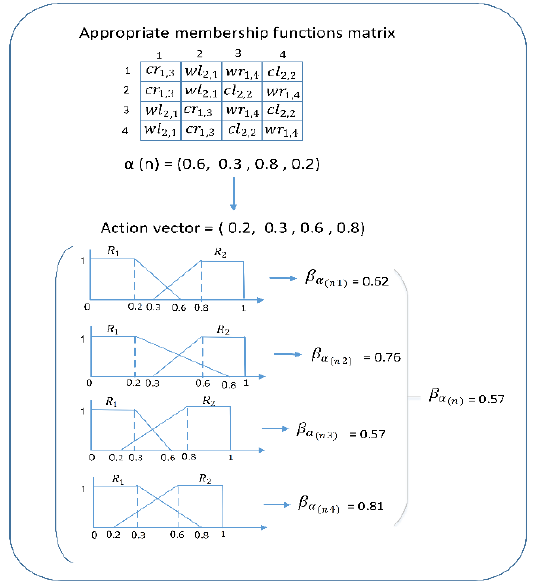
Figure 7. An example of finding objective function values.